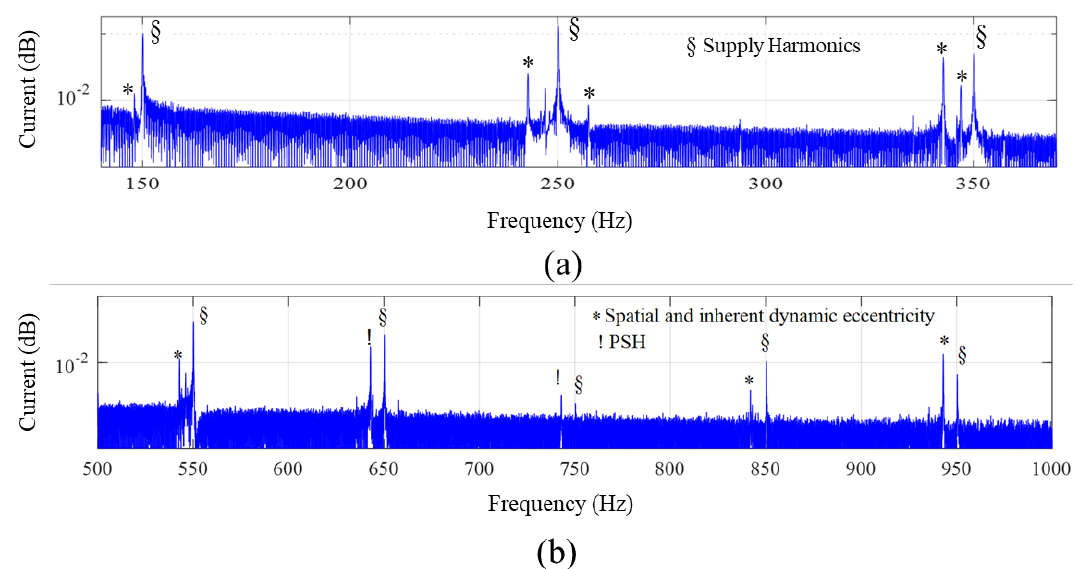
Figure 9. The generation of spatial harmonics in the stator current of the healthy machine ( a ) under a steady state regime with 50% of the rated load in the bandwidth of 100–400 Hz and ( b ) under a steady state regime with 50% of the rated load in the bandwidth of 500–1000 Hz.